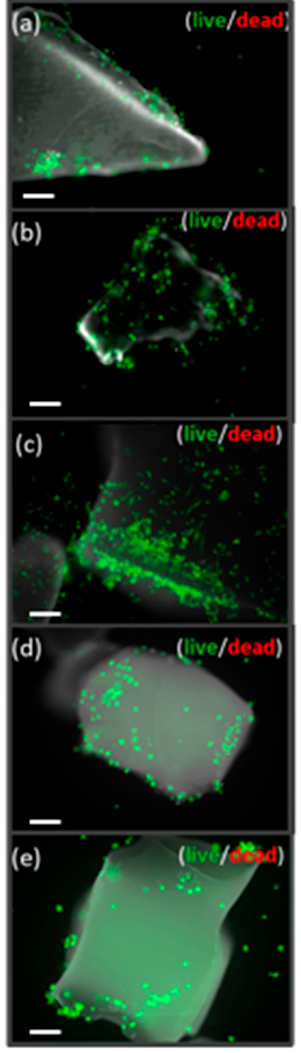
Figure 8. Live/dead staining of one-week HOB culture. HOB cultures with xerogels: SCS8 T10 ( a ), SCS8 T10 E1 ( b ), SCS8 T10 E7 ( c ), SCS8 E1 ( d ), and SCS8 E7 ( e ). Live cells appear green; the nuclei of dead cells stained in red and xerogels in gray. Scale bar represents 100 μ m.